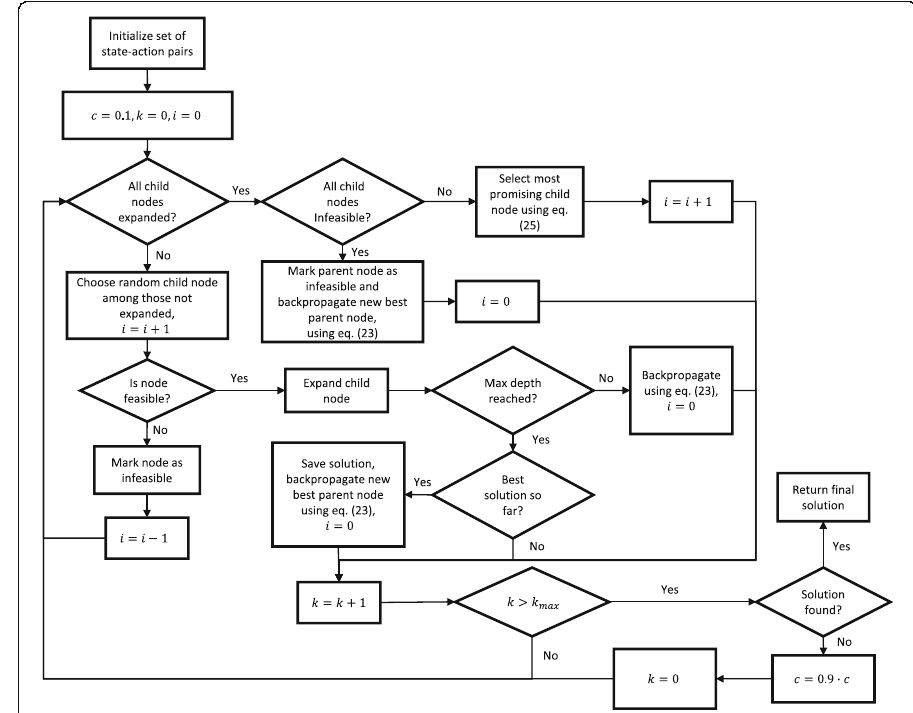
Fig. 5 Flowchart of the MCTS